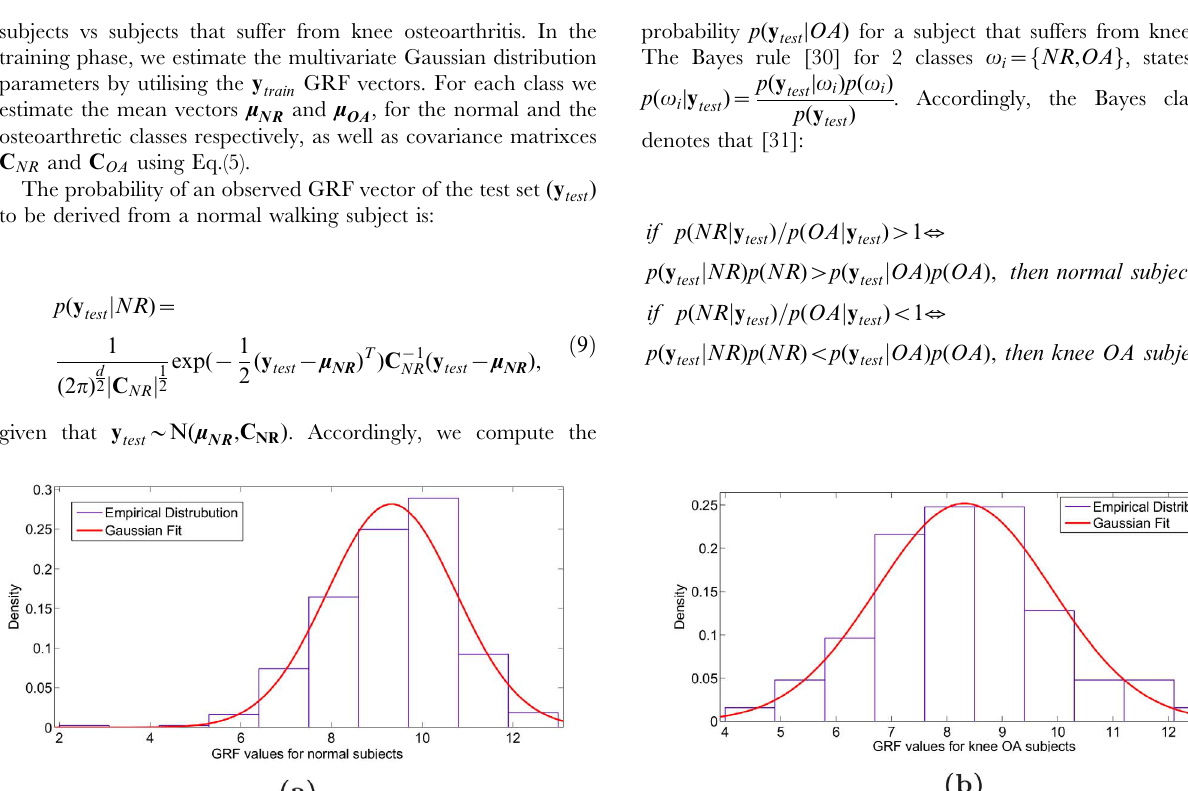
Figure 3. GRFs for an random indicative subject.